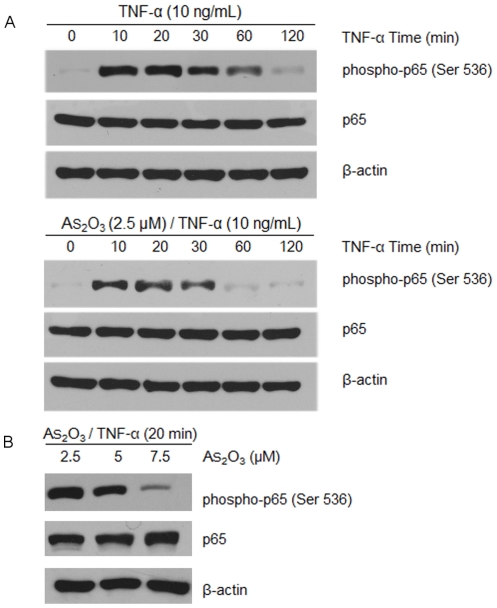
As2O3 inhibits TNF-α dependent p65 phosphorylation.(A) Cells were either untreated or pretreated with 2.5 µM As2O3 for 6 hours and then treated with 10 ng/mL TNF-α for 0, 10, 20, 30, 60, 120 minutes time points. (B) Cells were incubated with 2.5 µM, 5 µM, 7.5 µM As2O3 for 6 hours and then treated with 10 ng/mL TNF-α for 20 minutes. Western blot analysis was performed with anti-p65 and anti-phospho- p65-Ser 536.